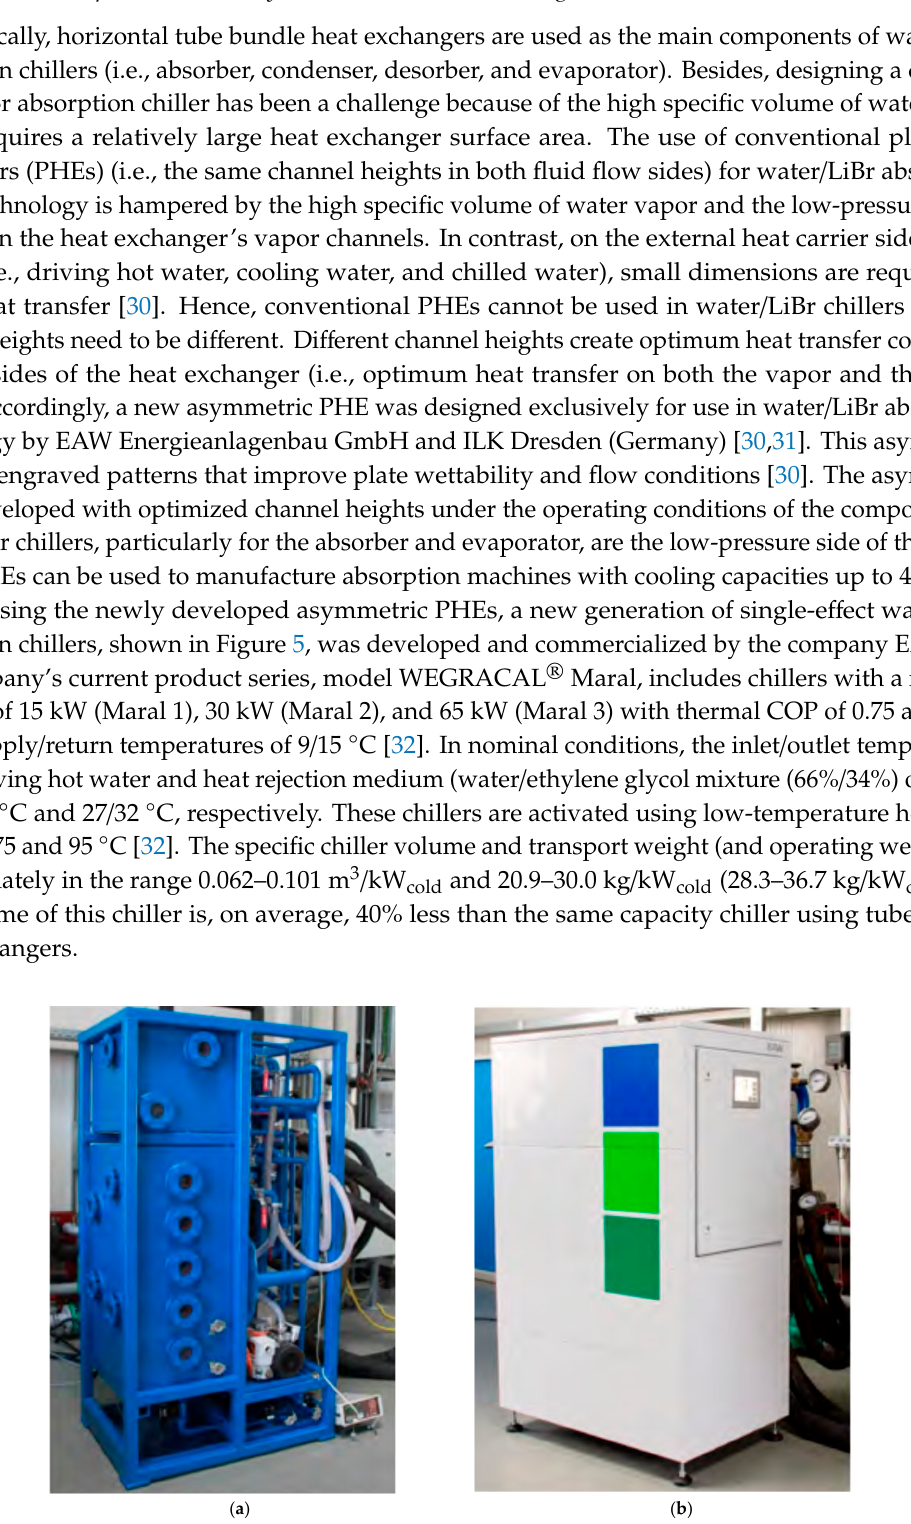
Figure 5. A 30 kW single ‐ effect water/LiBr absorption chiller machine using an asymmetric plate heat exchanger technology from EAW Energieanlagenbau GmbH [30]. ( a ) Internal view of WEGRACAL ® Maral 2; ( b ) External view of WEGRACAL ® Maral 2. Reproduced with the permission of the International Institute of Refrigeration (https: // iifiir.org) + Richter et al.